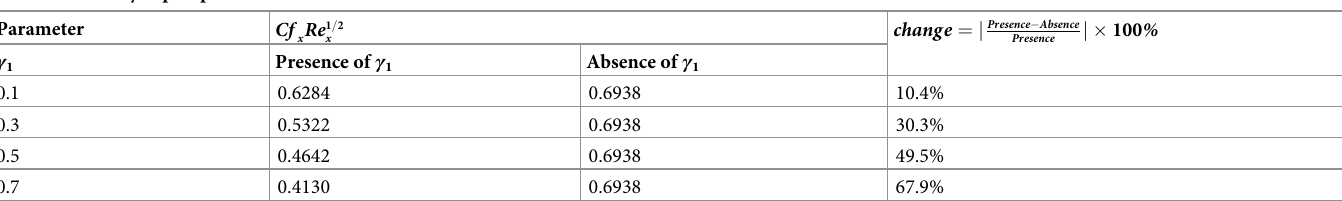
Table 5. Velocity slip impact on the skin friction coefficient.